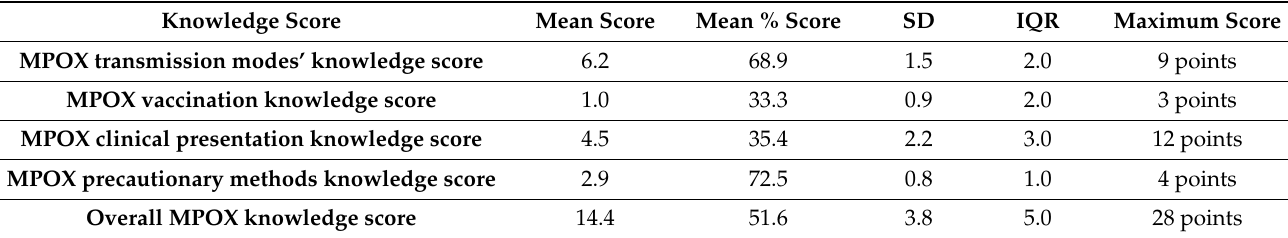
Table A3. HCWs’ knowledge scores. (KSA, 27 May to 5 June